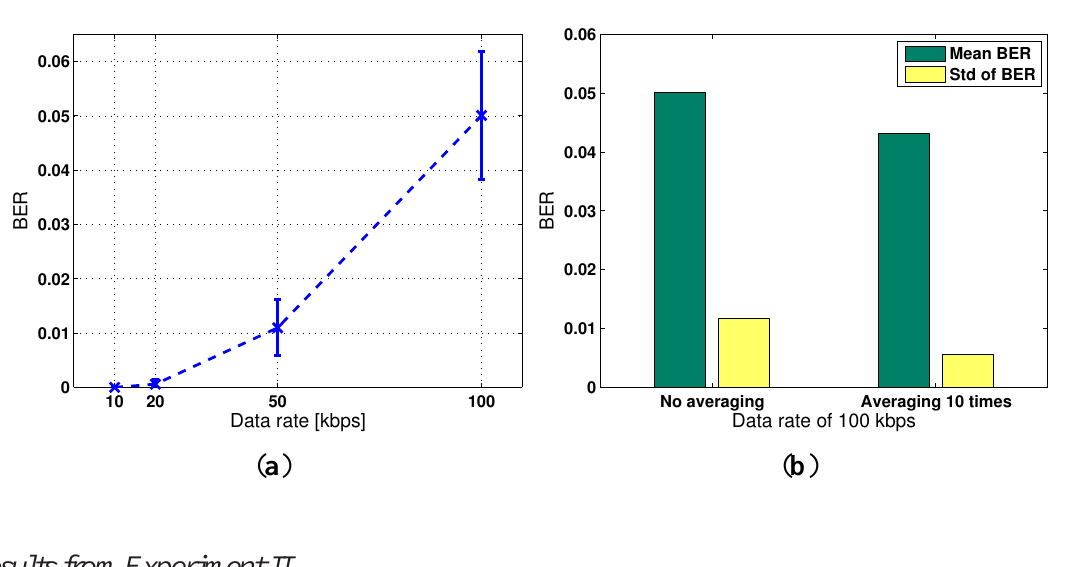
Figure 6. ( a ) Obtained bit error rate versus data rate at R = 10 , 20 , 50 , 100 kbps; ( b ) impact of noise reduction by time